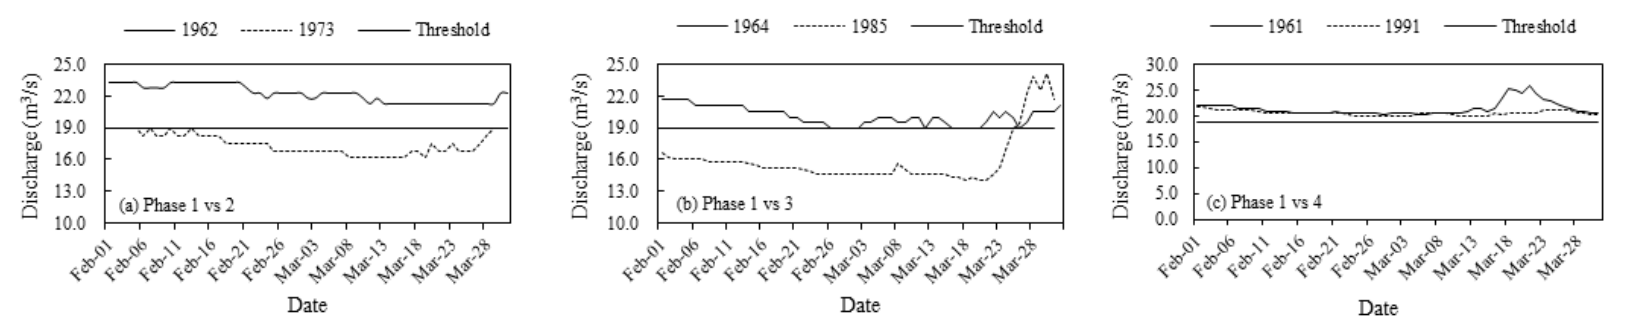
Figure 11. The comparison of duration of low flows in different phases during the forest harvesting period.